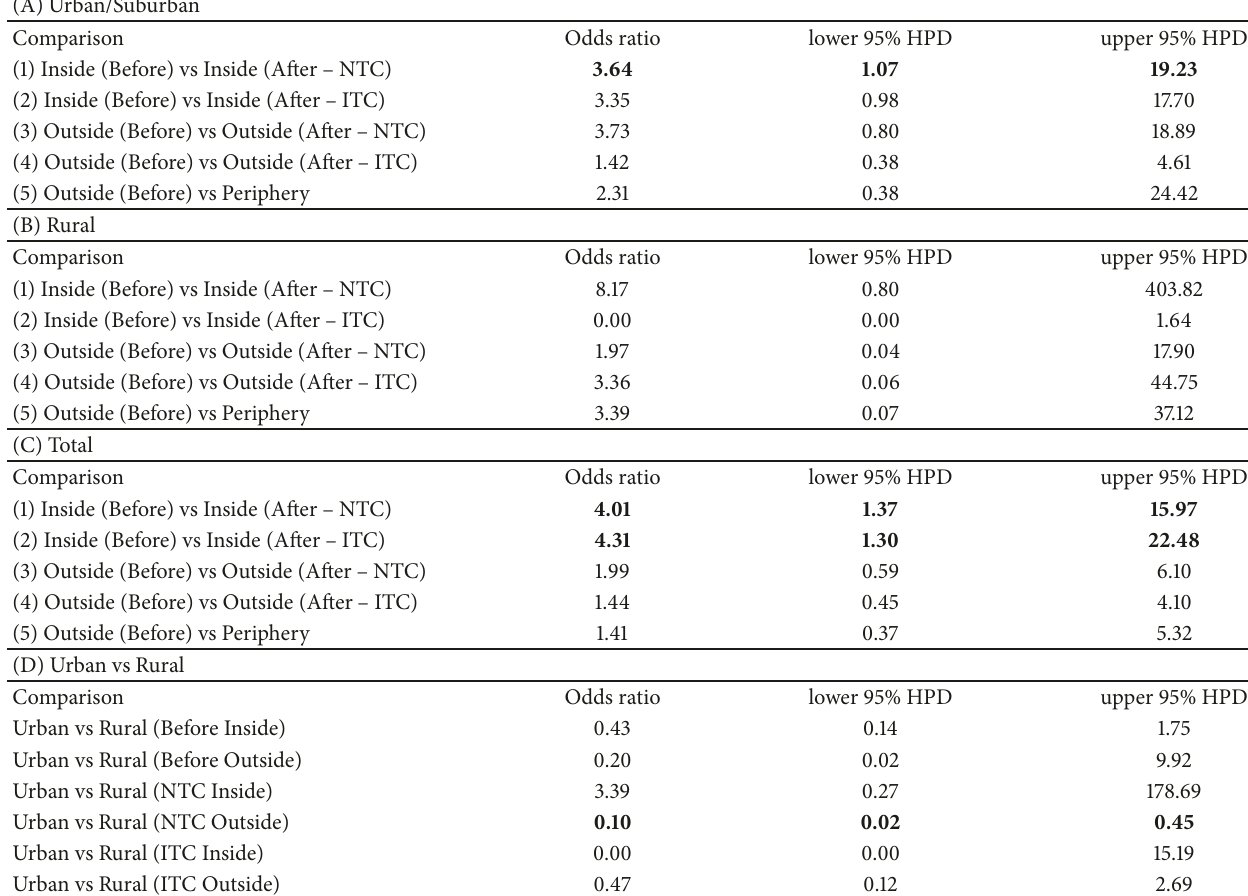
Table 6: Bayesian 95% highest posterior density (HPD) intervals for the odds ratios 1 of mosquito infection rates in control (NTC) and intervention (ITC)